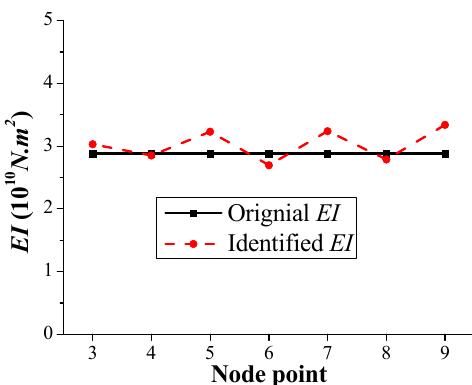
Figure 23. Identified EI results calculated by the frequency-domain method.